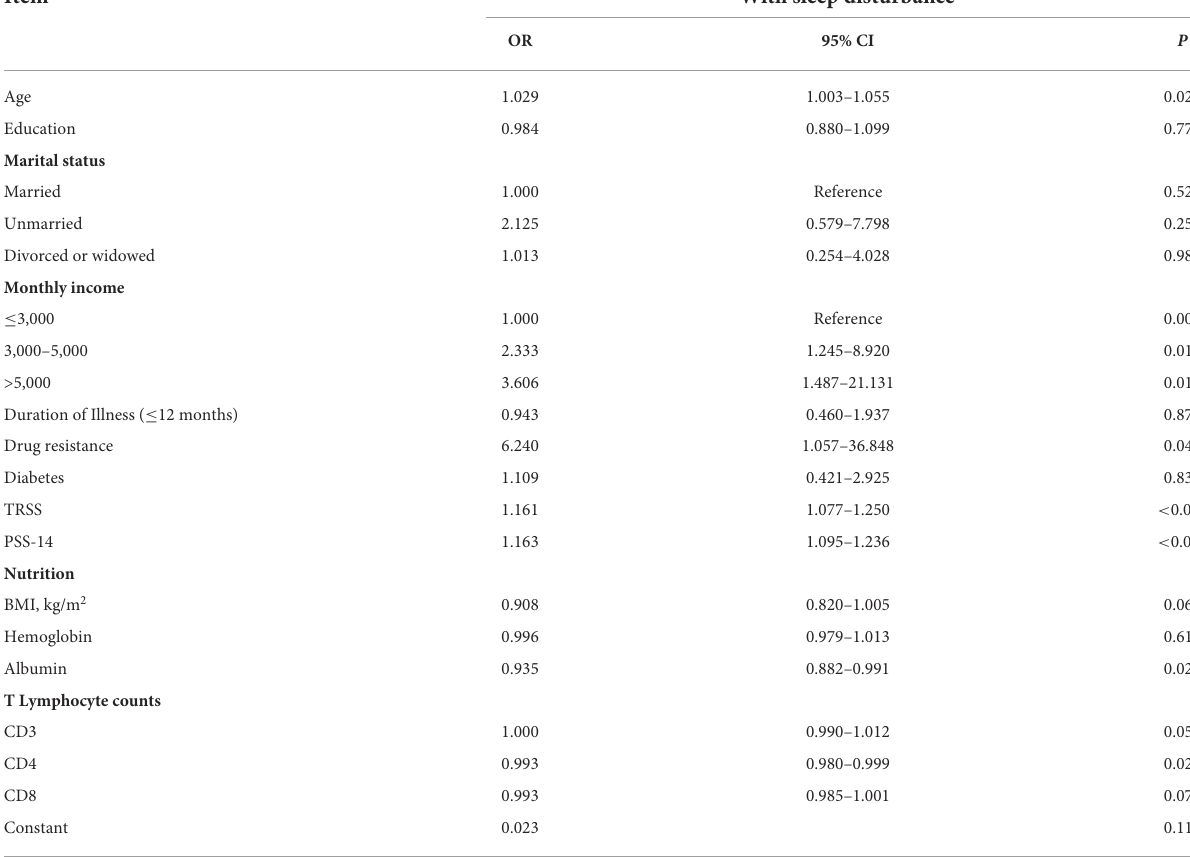
TABLE 4 Logistic regression analysis of associated factors in tuberculosis patients with sleep